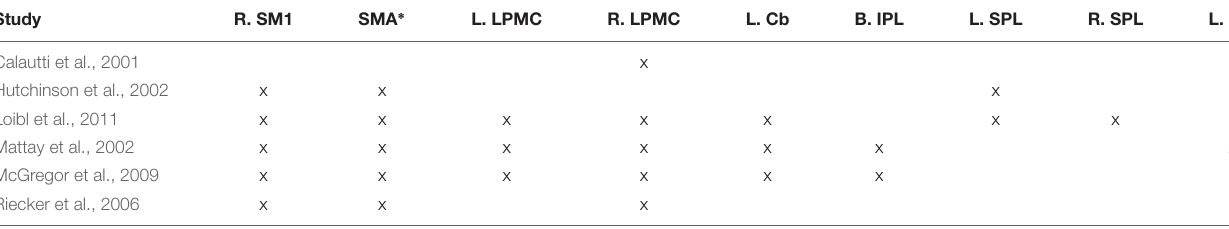
TABLE 1 | Locations of activations from fMRI and PET studies of the aging motor